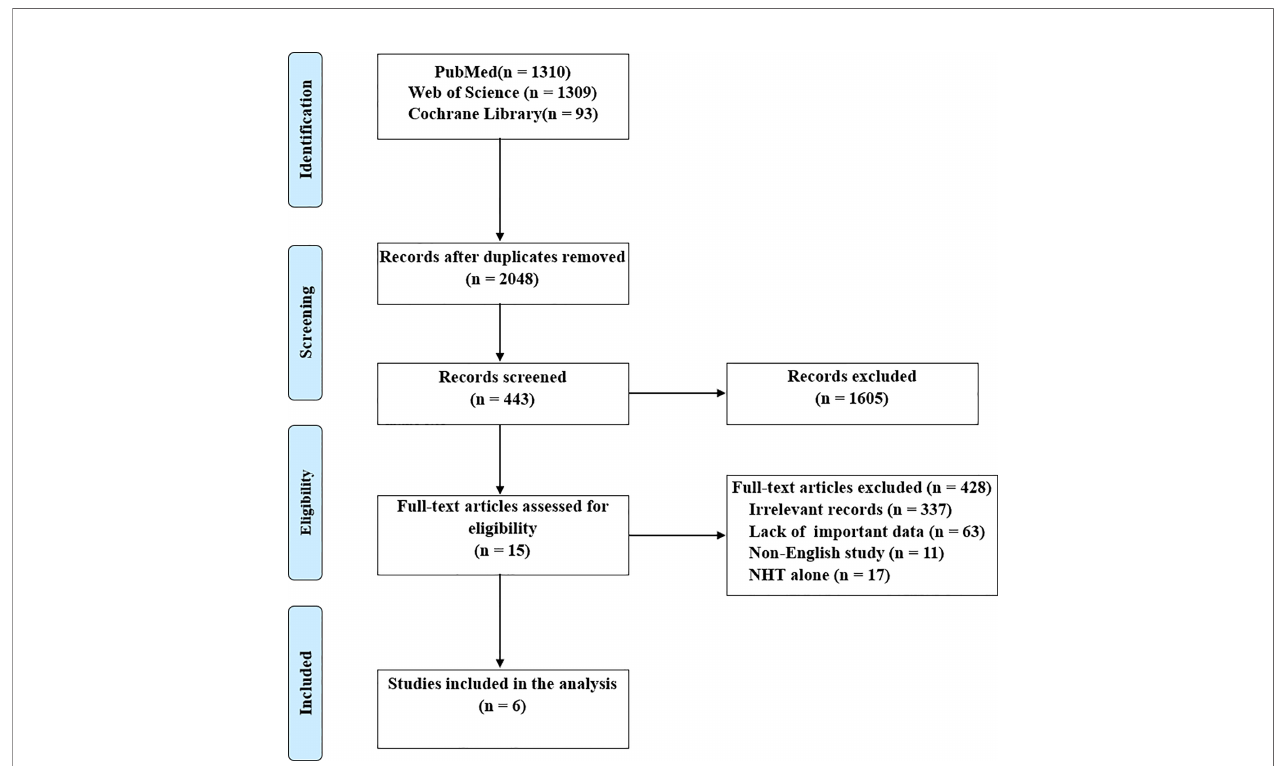
FIGURE 1 | Preferred Reporting Items for Systematic Reviews and Meta-analysis (PRISMA) fl ow